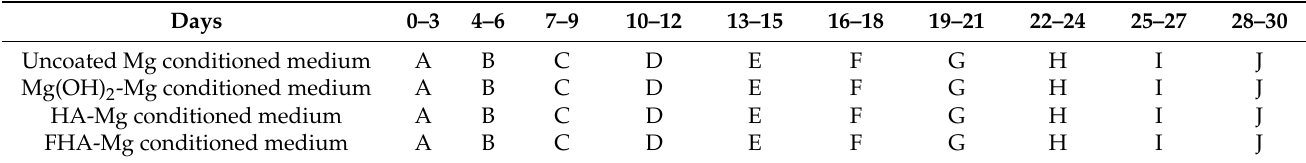
Table 1. Collection time period of Mg 2+ conditioned media from Mg-based